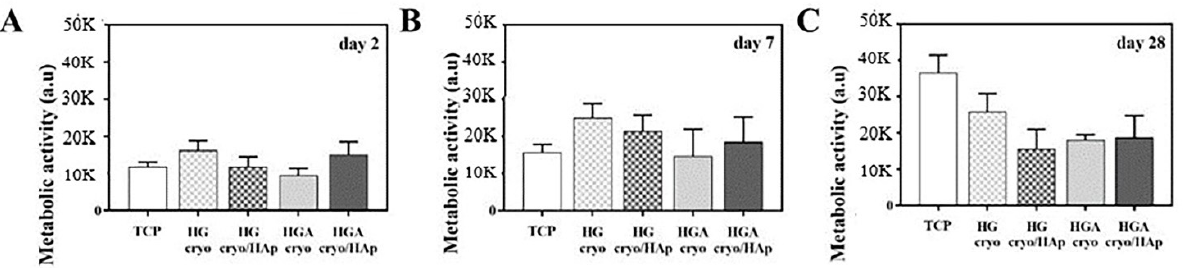
Figure 6. Alamar blue assay. Determination of the total cell metabolic activity after culture cells for 2 ( A ), 7 ( B ), and 28 days ( C ) on scaffolds (HG cryo , HG cryo /HAp, HGA cryo , HGA cryo /HAp). Values represent the mean ± SD ( n = 4/group).